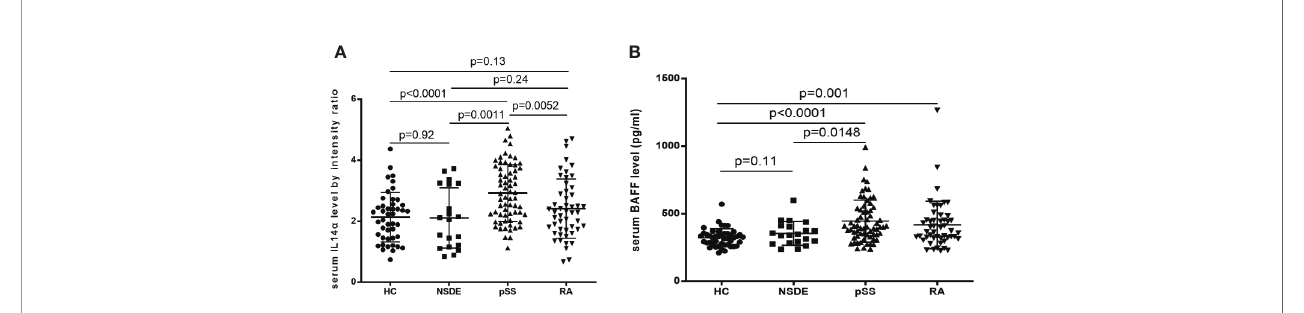
FIGURE 1 | (A) Relative intensity ratio for serum IL-14 a levels in HC, NSDE, pSS, and RA groups. (B) Serum BAFF levels in HC, NSDE, pSS, and RA